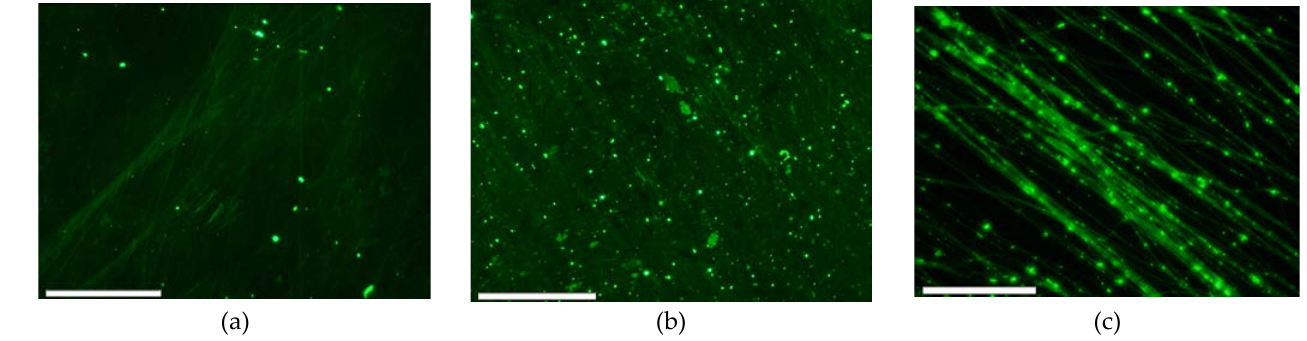
Figure 7. Cell proliferation as demonstrated by labeled nuclei of ( a ) PCL (Control), ( b ) PCL-GSH-GLU and ( c ) PCL-GSH-PBS. The value in the scale bar is 500 µm.